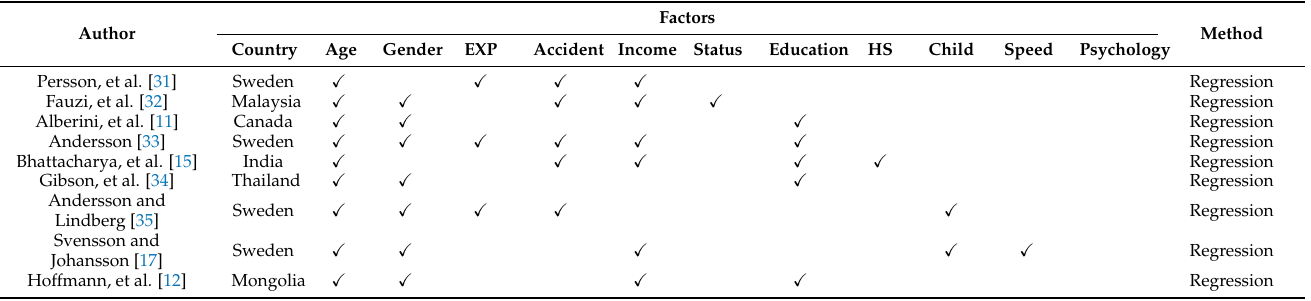
Table 1. Summary of previous studies on WTP for accident risk reduction and relevant